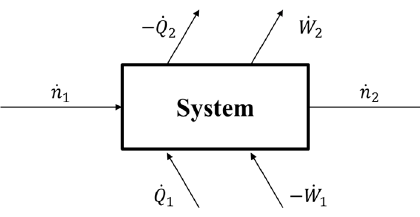
Figure 3. General balance of matter and energy on a general steady-state thermal system.